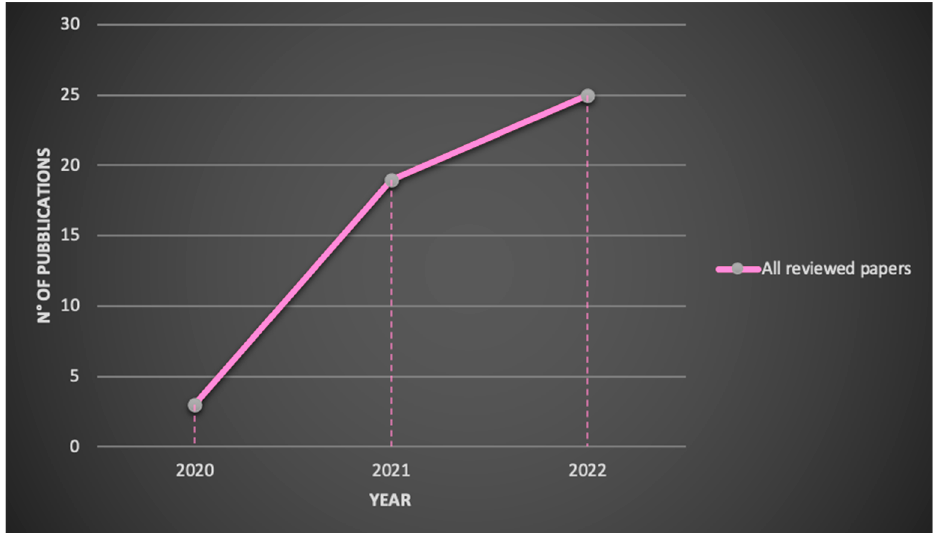
Figure 3. Reviewed publications related to HoloLens 2 research by year.